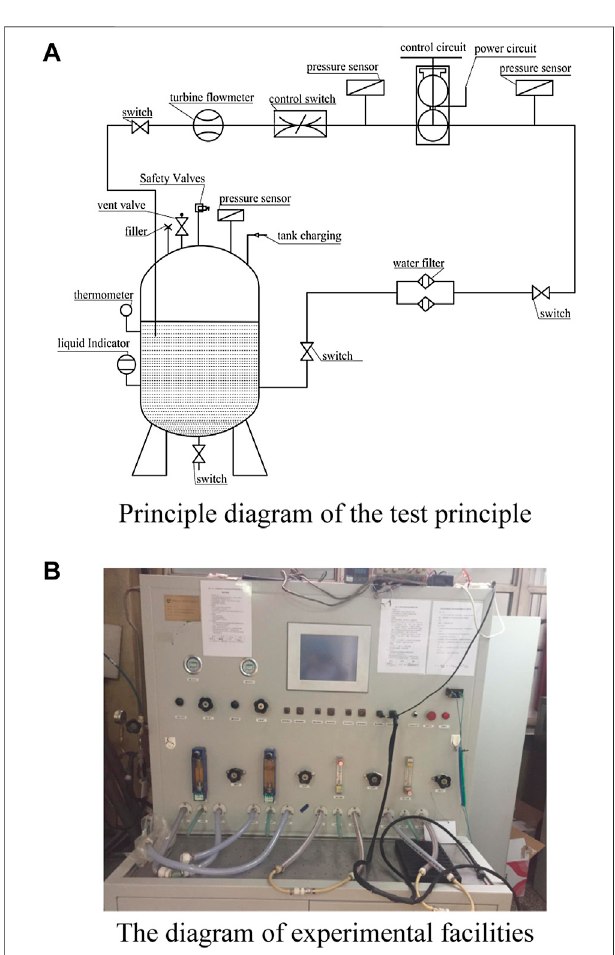
FIGURE 5 | The centrifugal pump experimental